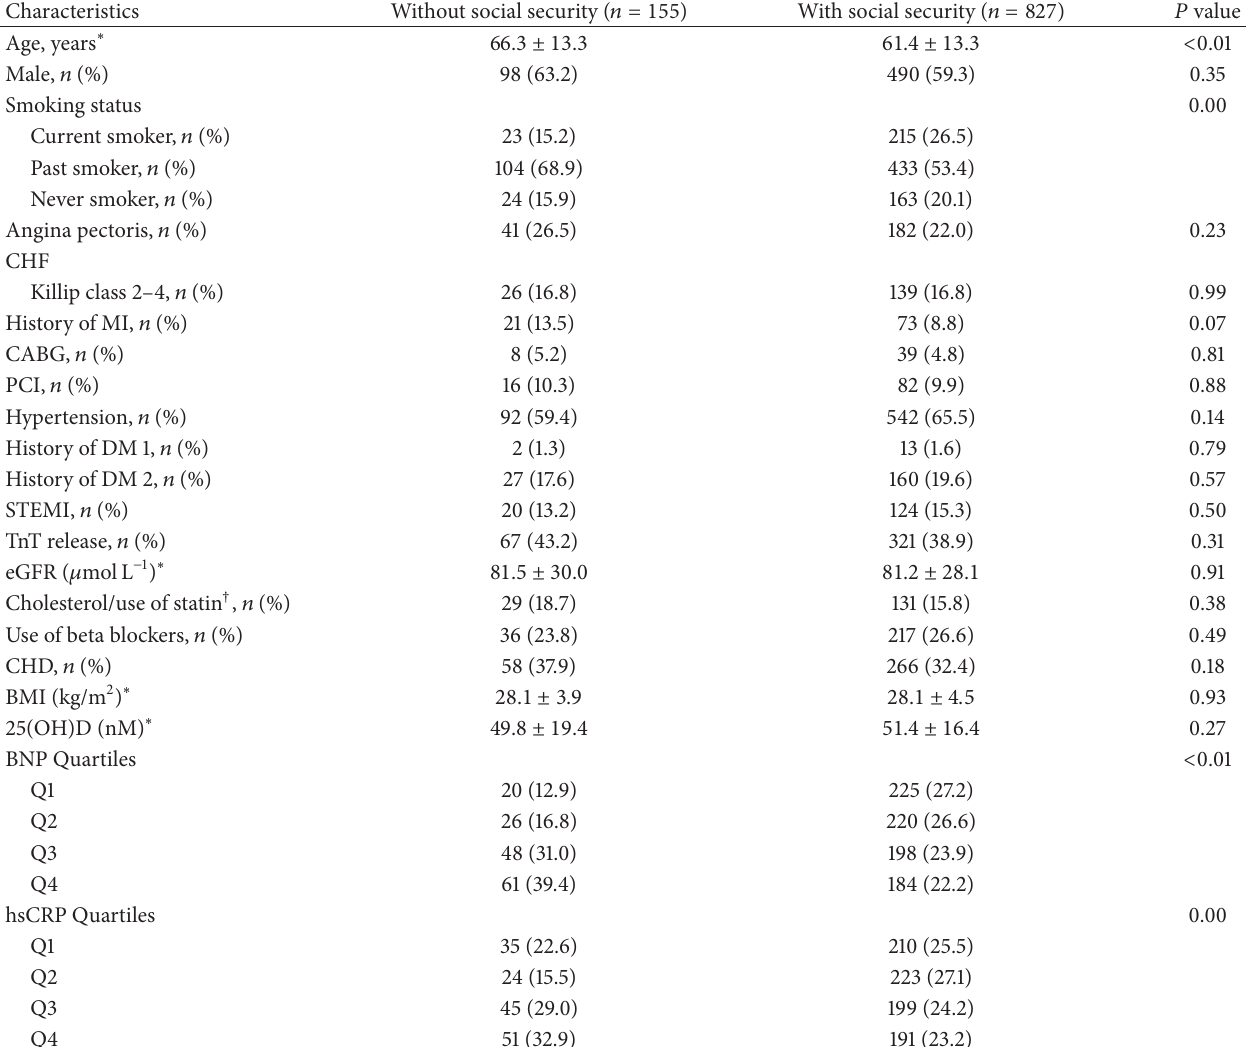
Table 3: Baseline characteristics for patients with and without social